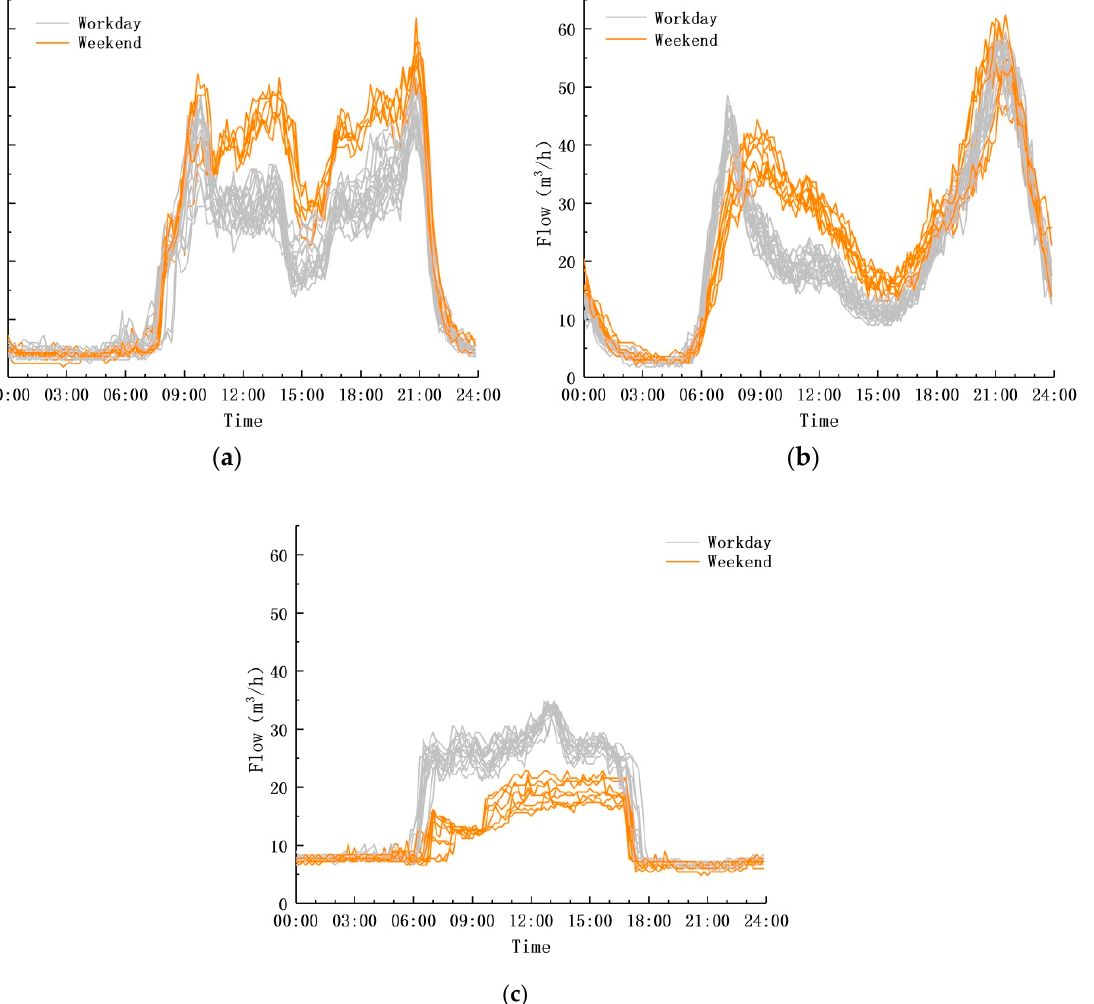
Figure 4. Water consumption curves in a month: ( a ) a commercial user; ( b ) a residential user; ( c ) an industrial user.